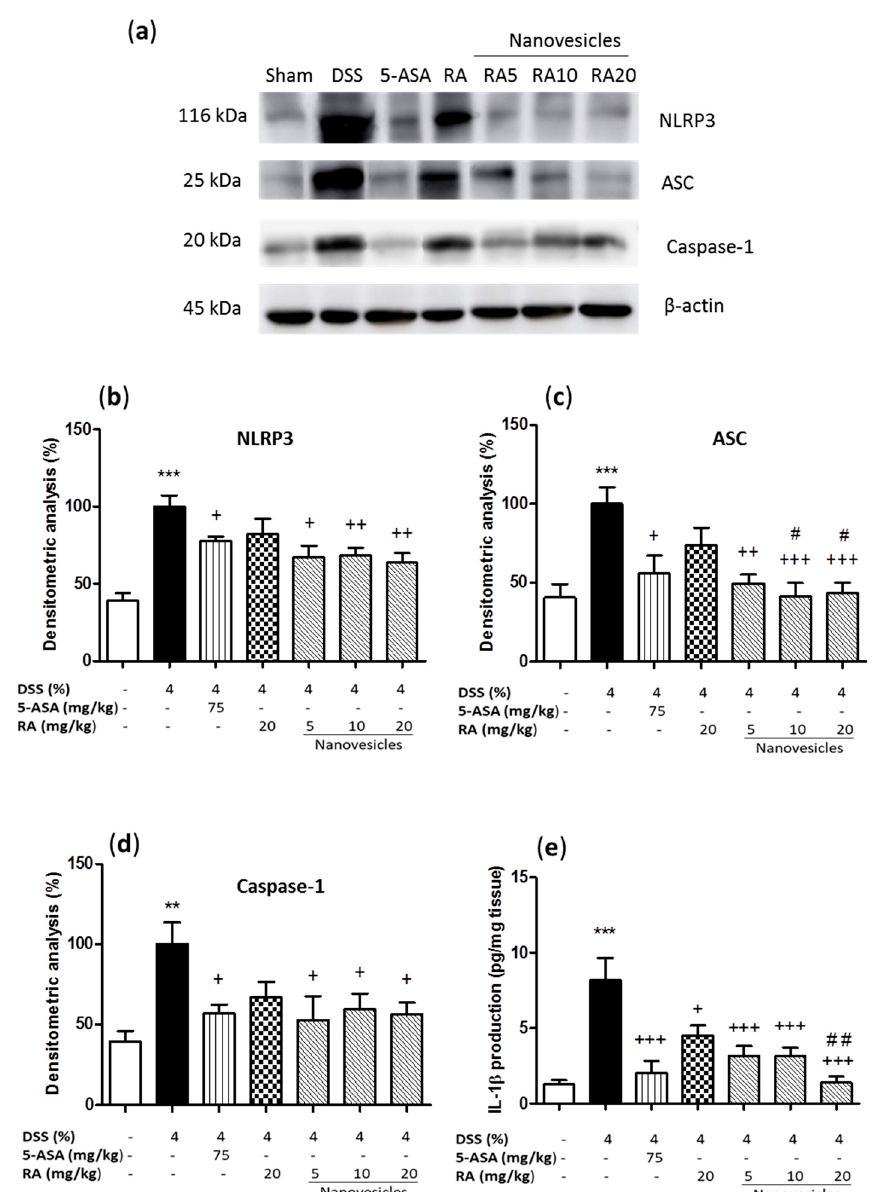
Figure 5. Effects of rosmarinic acid (RA)-loaded nanovesicles (5, 10 and 20 mg/kg), RA (20 mg/kg) or aminosalicylic acid (5-ASA) (75 mg/kg) on inflammasome components expression and IL-1 β levels in DSS-induced colitis in mice. ( a ) Representative Western blot analysis of inflammasome proteins. Densitometry analysis of ( b ) nucleotide-binding domain, leucine-rich-repeat-containing family, pyrin domain- containing 3 (NLRP3), ( c ) inflammasome adaptor protein (ASC) and ( d ) caspase-1 were performed following normalization to the control ( β -actin housekeeping gene). ( e ) IL-1 β production was evaluated by ELISA assay. Results are representative of five experiments performed on different simples. Data are expressed as the mean ± SEM. Mean value was significantly different compared with the sham group (** p < 0.01, *** p < 0.001; Mann–Whitney U test). Mean value was significantly different compared with DSS group (+ p < 0.05, ++ p < 0.01, +++ p < 0.001; Kruskal–Wallis test) or RA group (# p < 0.05, # # p < 0.01; Kruskal–Wallis test).